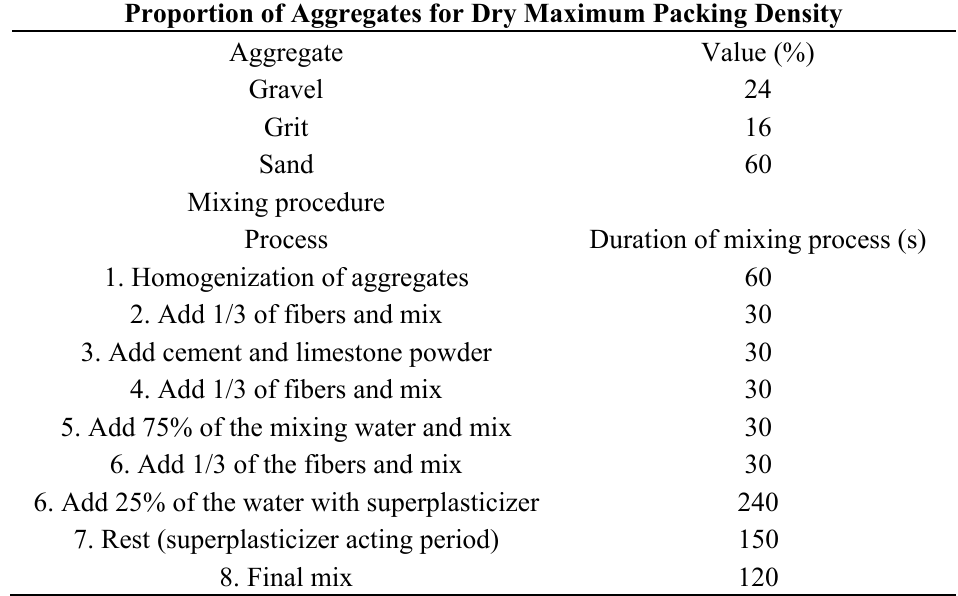
Table 1. Proportion of aggregates for dry maximum packing density and mixing procedure